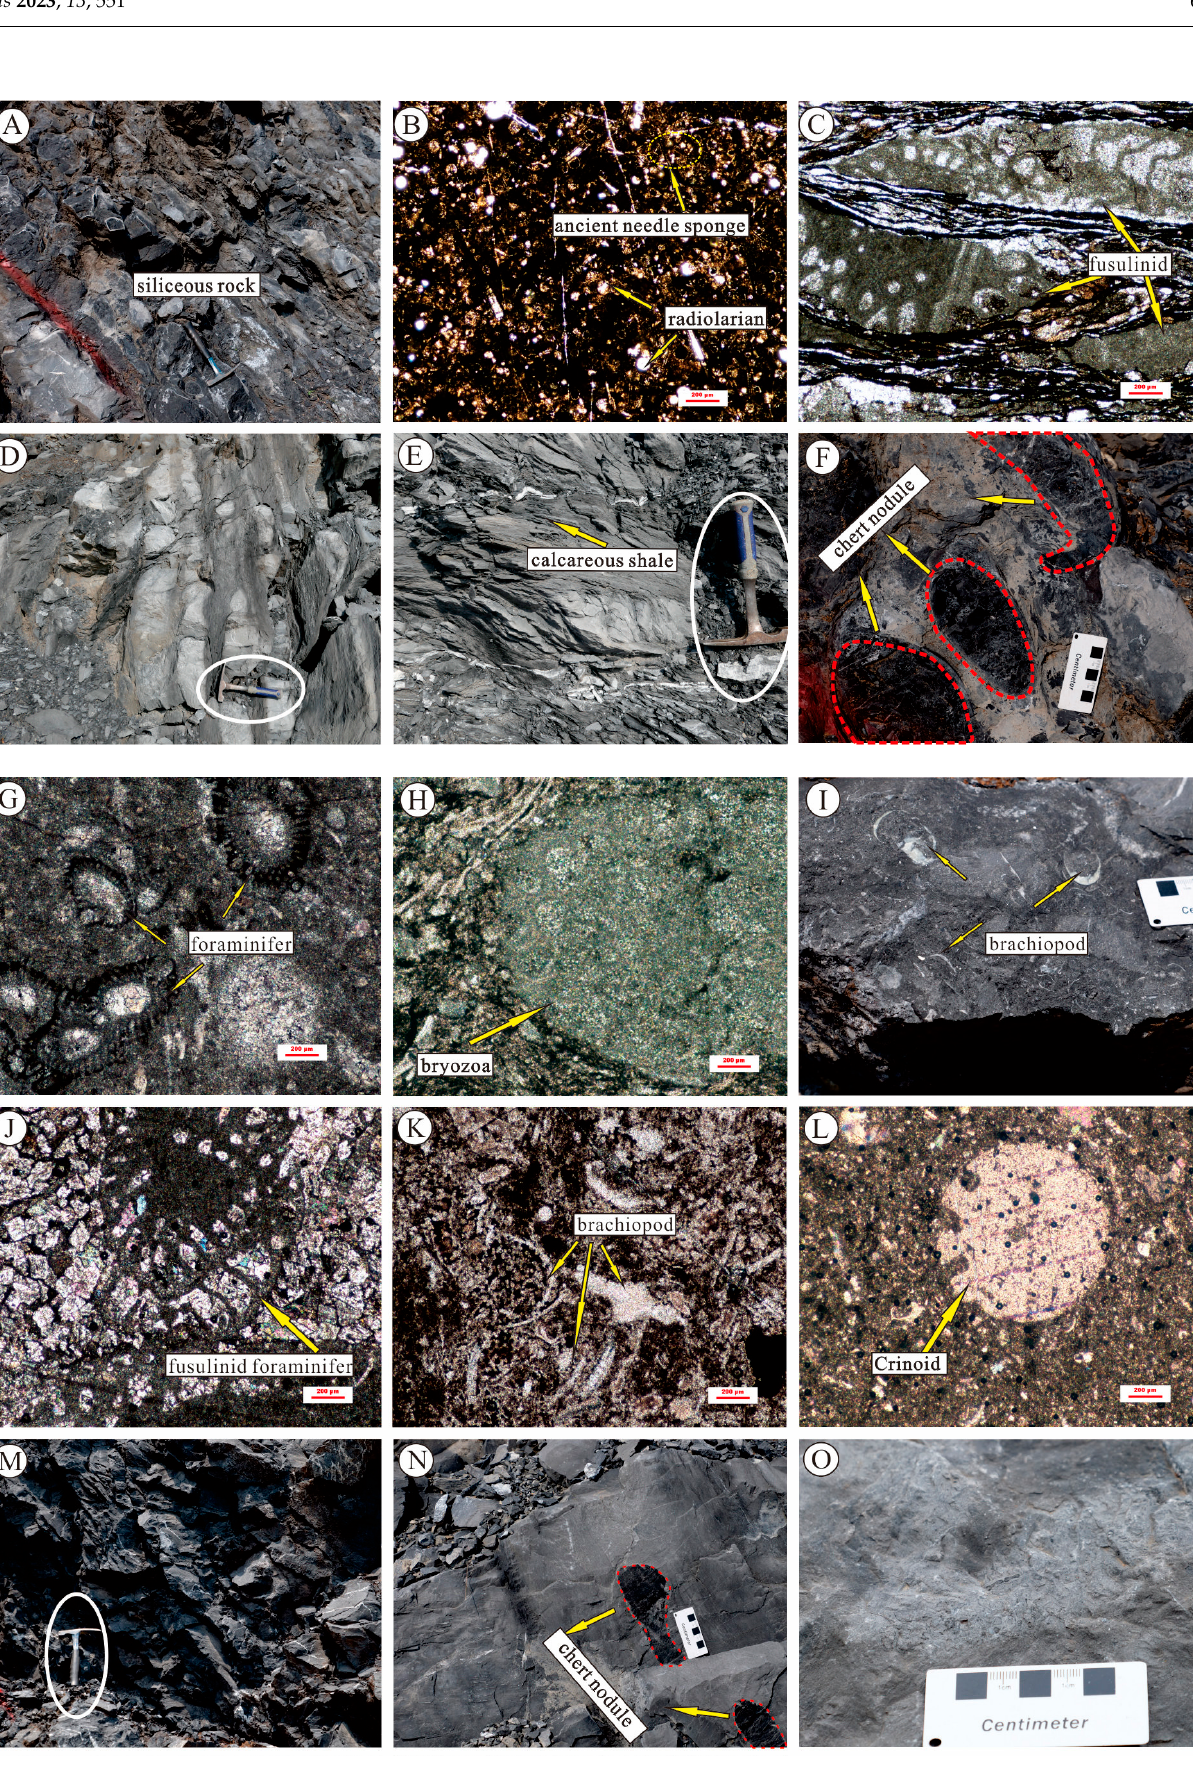
Figure 3. Typical rock types from the Putaoling section collected from the Lower Yangtze region. ( A ) A thin black layer of siliceous rock. ( B ) Siliceous rocks that contain abundant radiolarians and sponge spicules of different sizes. ( C ) Wackestones that contain abundant foraminifera. ( D ) Lime- stone intercalated with dark grey calcareous shale. ( E ) Calcareous shale. ( F ) Limestone with abundant black lenticular or nodular chert. ( G ) Foraminifera. ( H ) Bryozoan. ( I ) Abundant brachi- opods can be seen in the bioclastic limestone. ( J ) Foraminifera. ( K ) Brachiopods. ( L ) Crinoids. ( M ) Medium-bedded wackestone. ( N ) Nodular chert. ( O ) Thick-bedded packstone, abundant bioclasts. ( P ) Corals. ( Q ) Limestone intercalated with a coal seam. ( R ) Abundant brachiopod fossils.